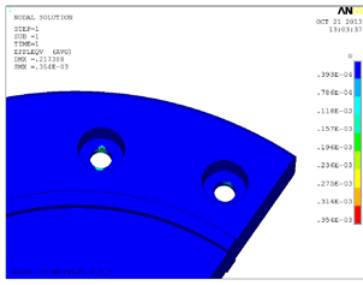
Fig. 8. Radial movements (a) and axial movements (b).